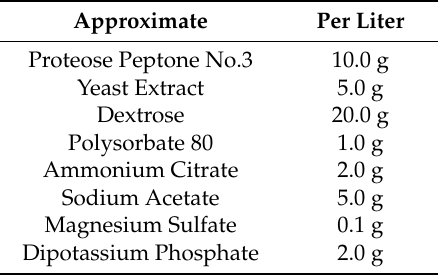
Table 1. Butterfly pea flower fermentation solution